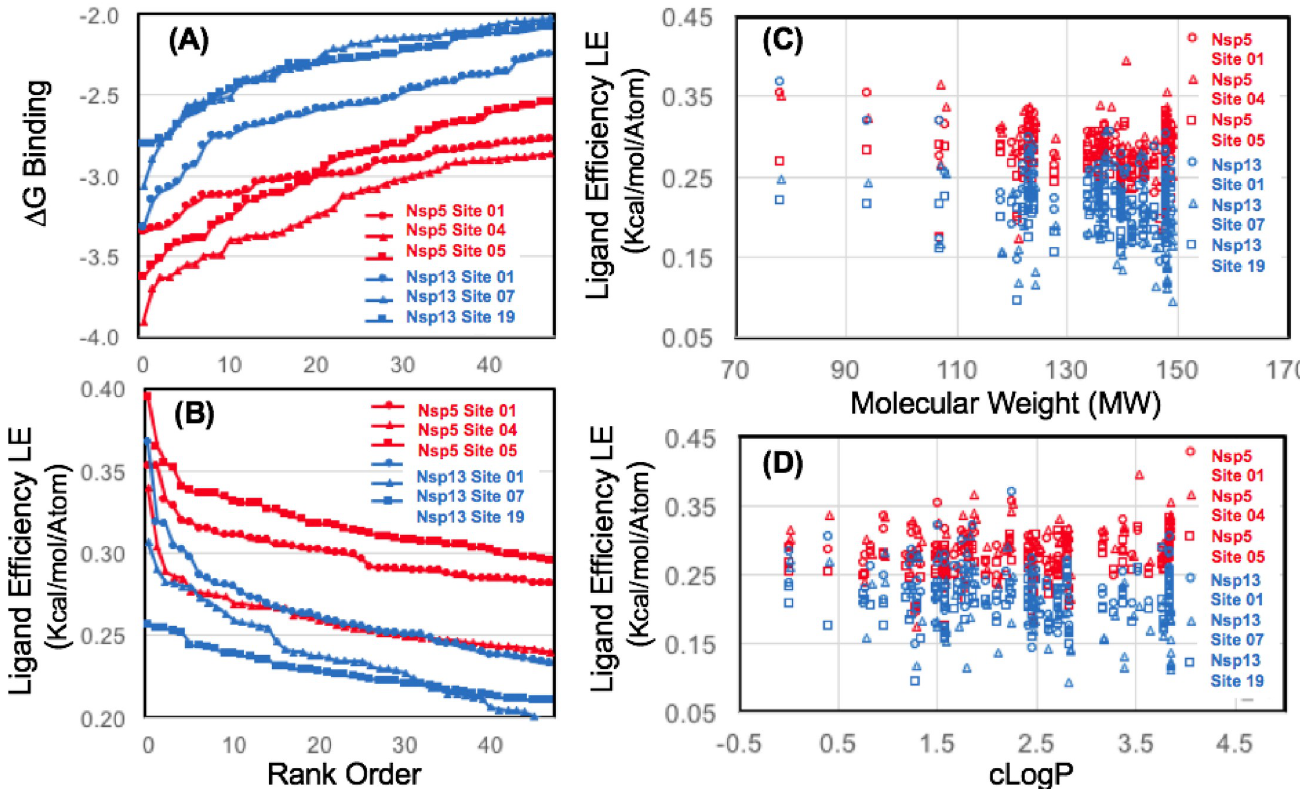
Fig 11. Ligand efficiency for several favorable binding sites on Nsp5 Mpro and Nsp13 helicase from computational fragment screening. Data is shown for Δ G bind (A) and ligand efficiency (B) comparing numerous sites using the FRAG100 library as a benchmark. Ligand efficiency data is also shown as a function of fragment molecular weight (C) and calculated LogP (D).